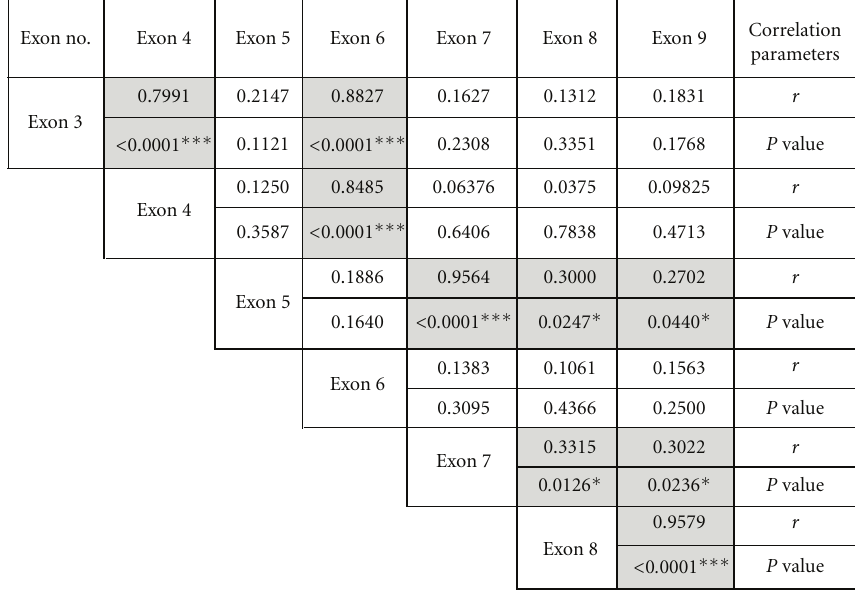
Figure 2: Correlation analysis between FHIT exons homozygous deletions. Correlation analysis was done using Pearson and Spearman correlation tests; “ r ” is correlation coe ffi cient. Highlighted values represent significant positive correlation between the two variables. ∗ P < 0 . 05, ∗∗∗ P < 0 .